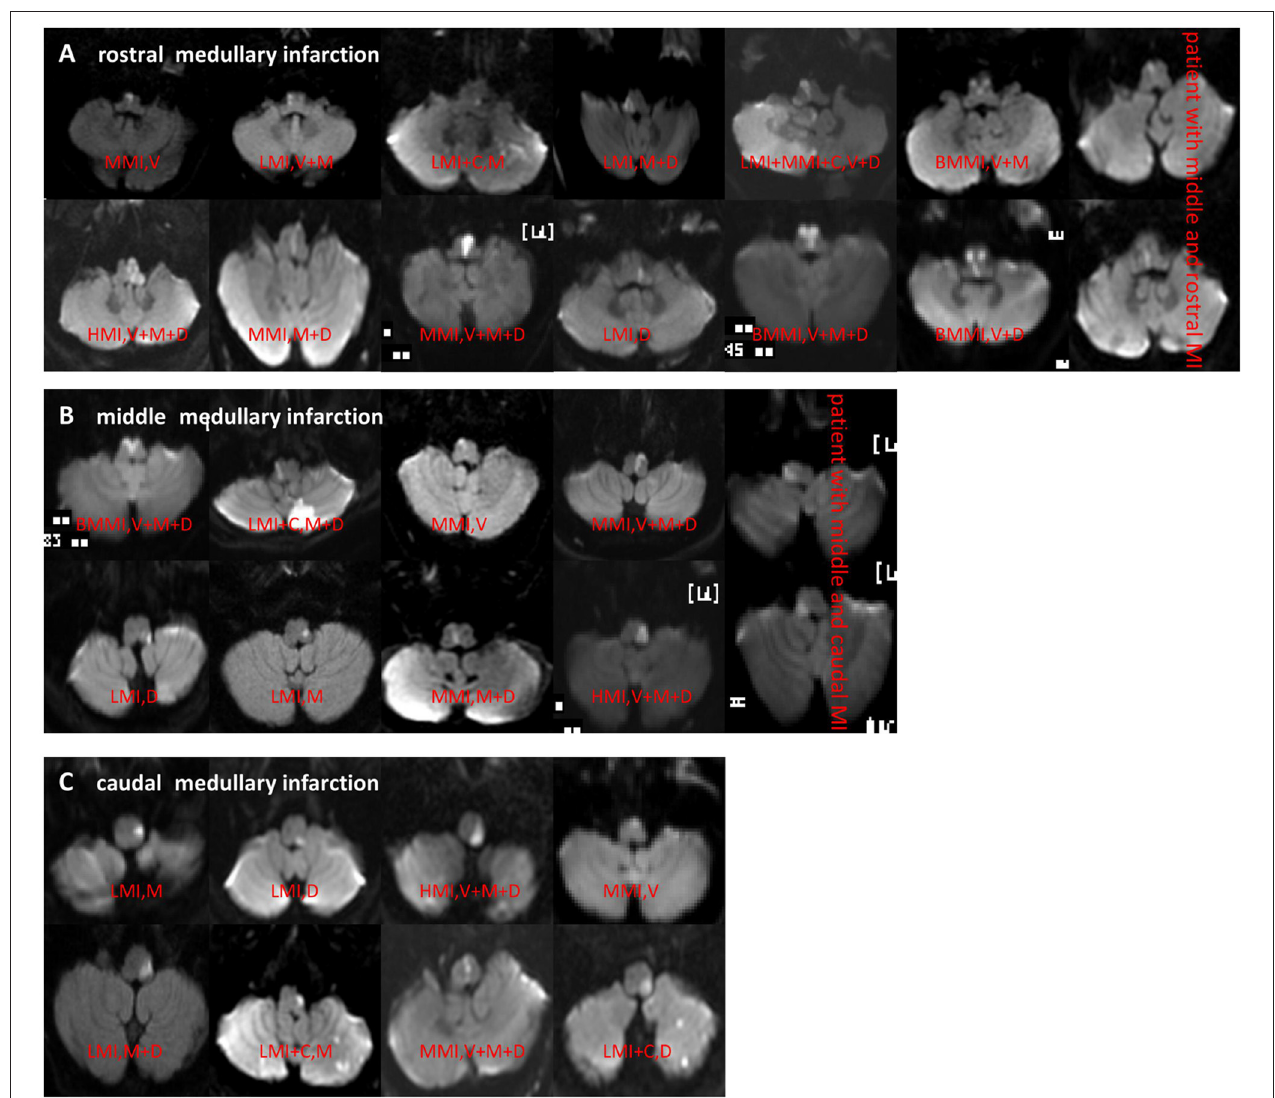
FIGURE 2 | (A–C) DWI showed different types of rostral, middle, and caudal MI. MI, medullary infarction; LMI, lateral MI; MMI, medial MI; BMMI, bilateral MMI; LMI + C, LMI + cerebellar infarction; MMI + C, MMI + cerebellar infarction; HMI, hemimedullary infarction; V, ventral; M, middle; D, dorsal.